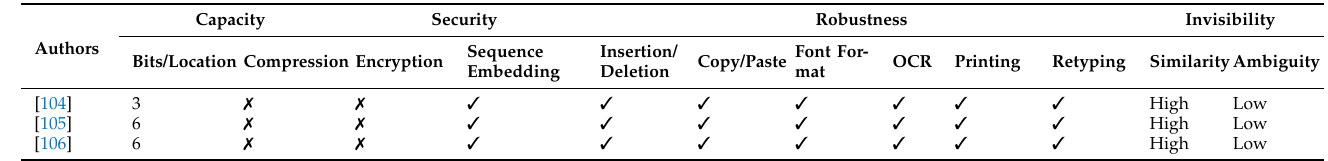
Table 24. Evaluation of sharp edges method based on invisibility and robustness and capacity.